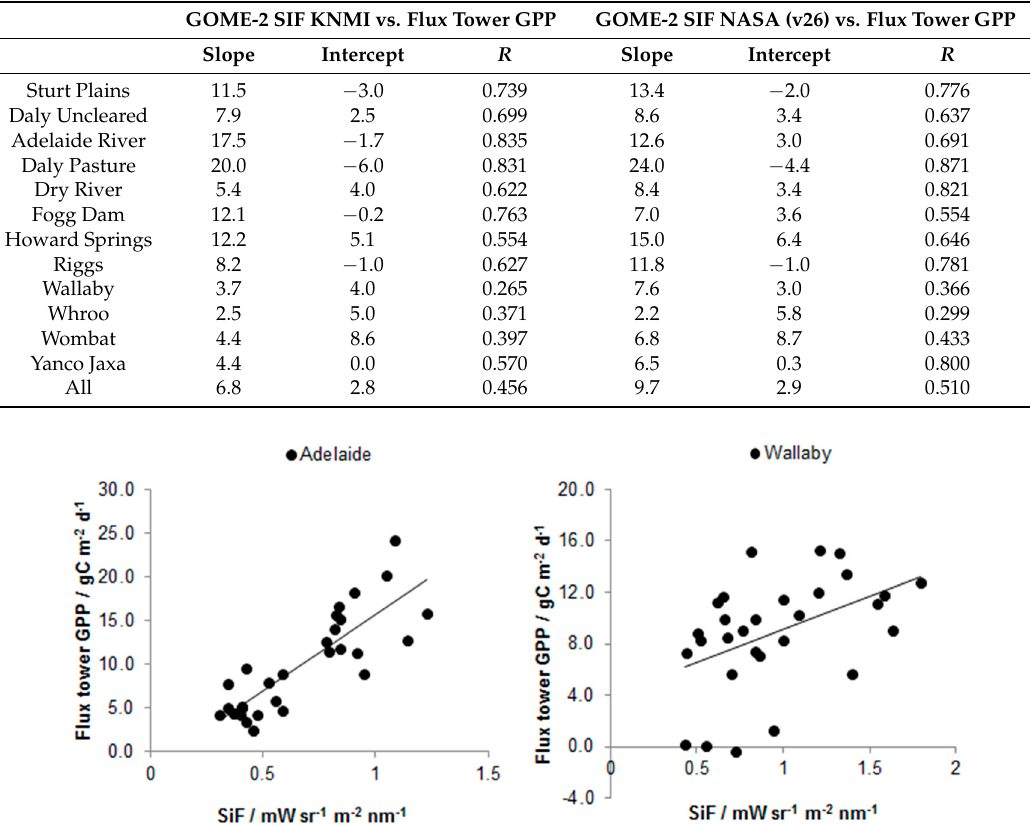
Figure 6. Sample scatterplots for the Adelaide (( left ) high correlation between GPP and SiF); and Wallaby (( right ) low correlation) sites.